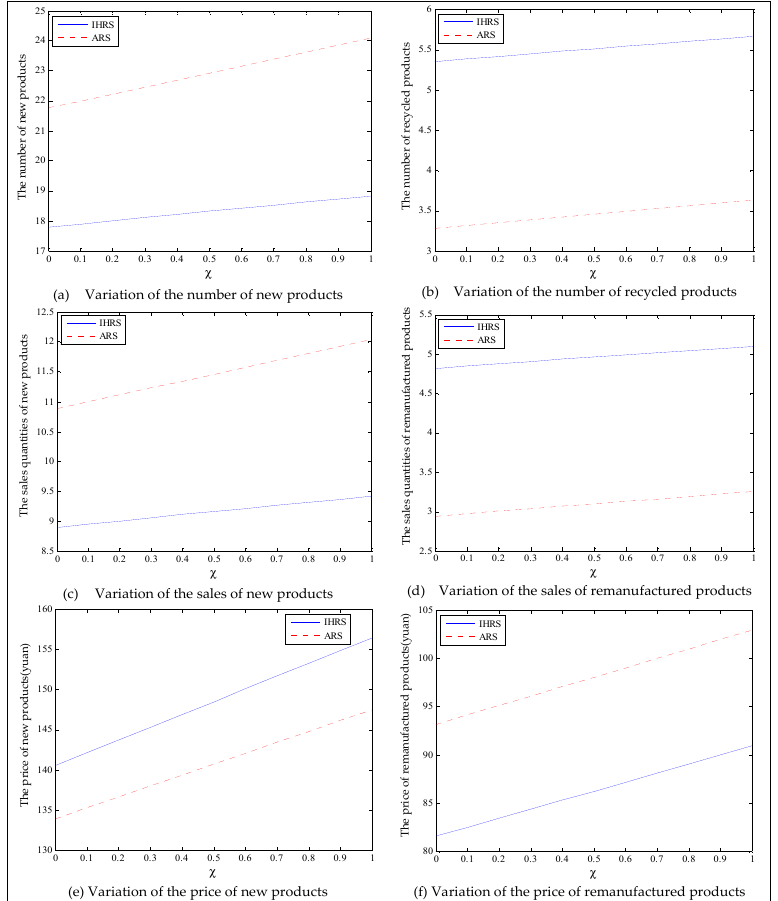
Figure 15. The variation of equilibrium strategies in Case 2 of Section 6.2.